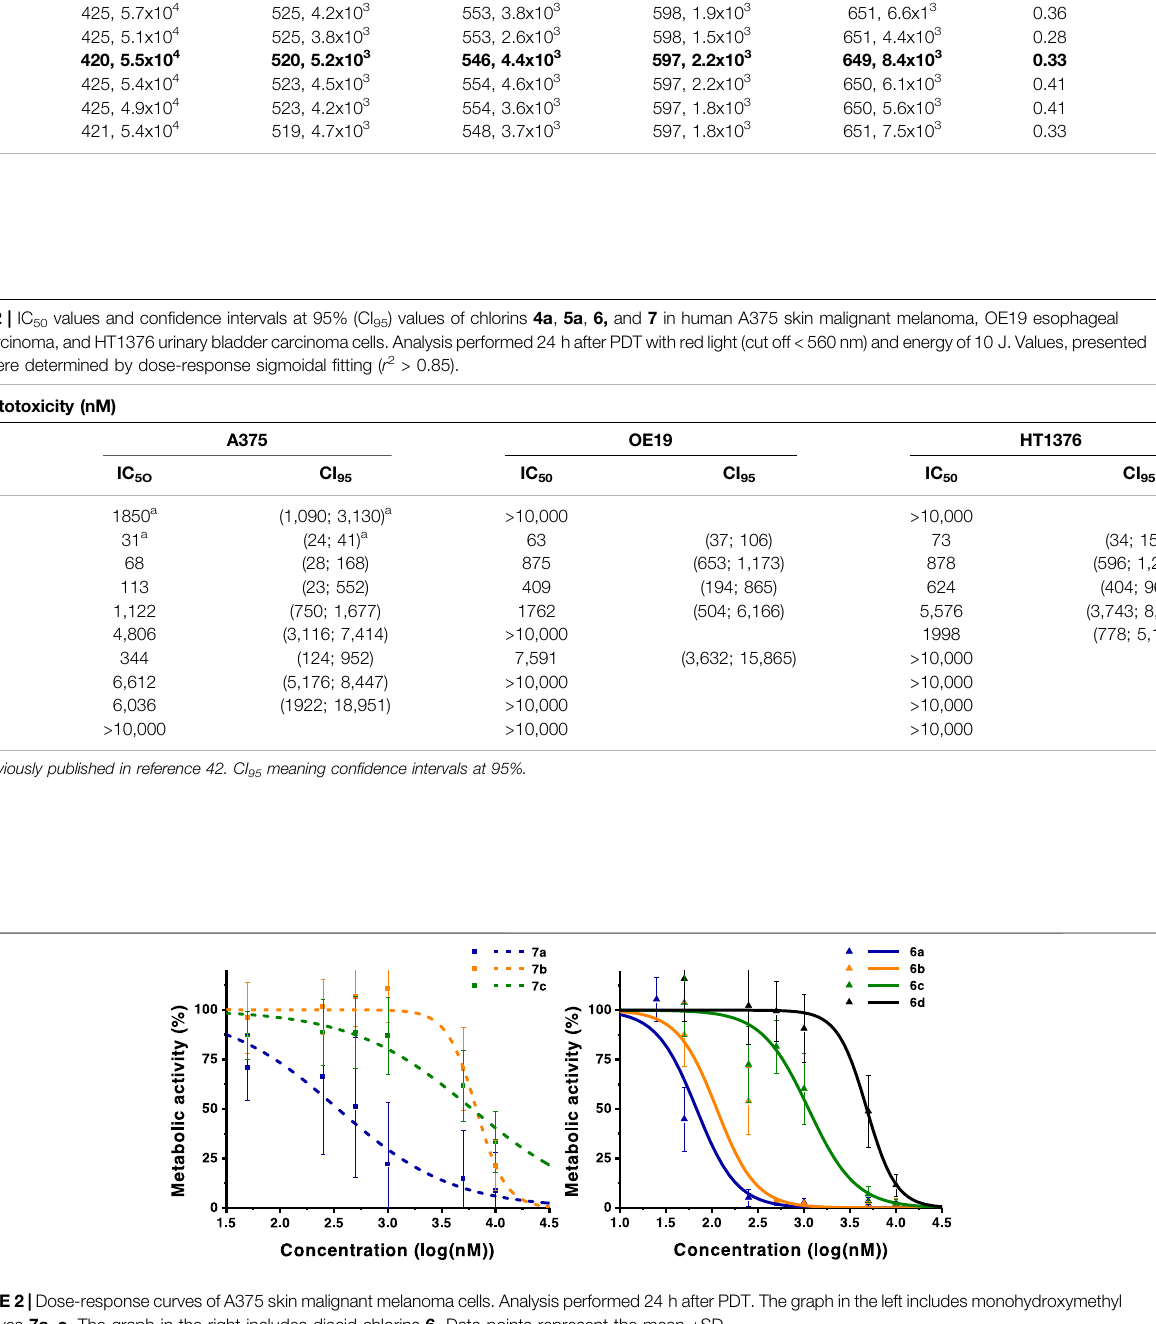
Frontiers in Chemistry |